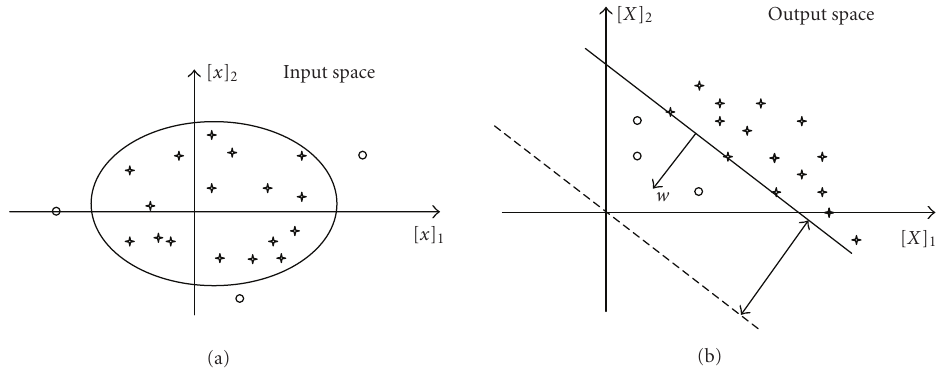
Figure 1: Data mapping by (a) one-class-SVM from input space to (b) output